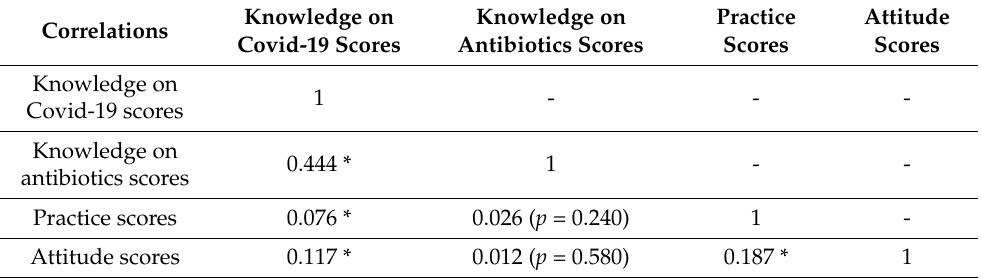
Table 8. Correlation matrix (Spearman) of knowledge on COVID-19, knowledge on antibiotics, attitude, practice